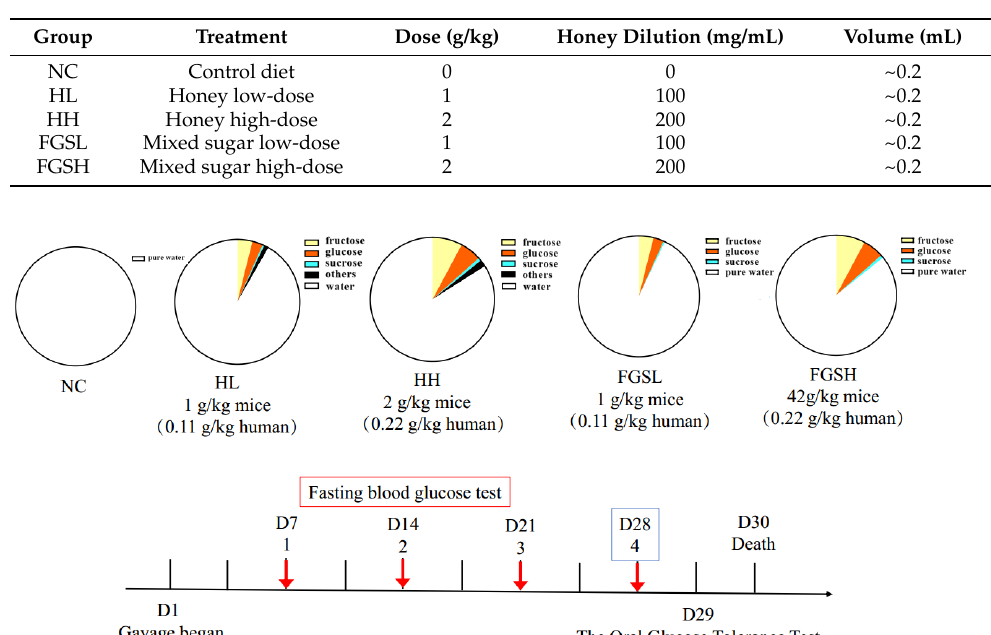
Table 1. Animal groups and doses.